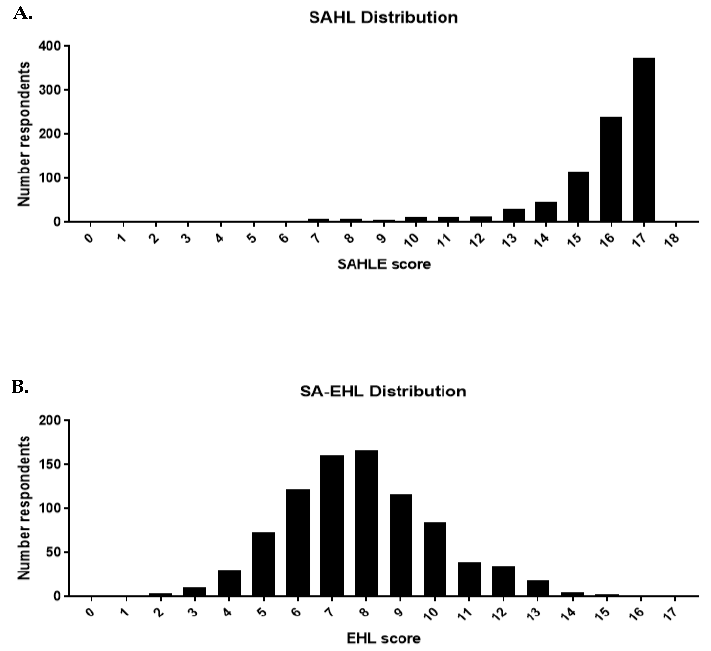
Figure 1. Distribution of responses per EHL scale. Distribution of SAHL ( A ) and SA-EHL ( B ) by score. The SAHL has a maximum score of 18. The SA-EHL has a maximum score of 17. n = 864. Table 3. Description of EHL levels and frequency of participant